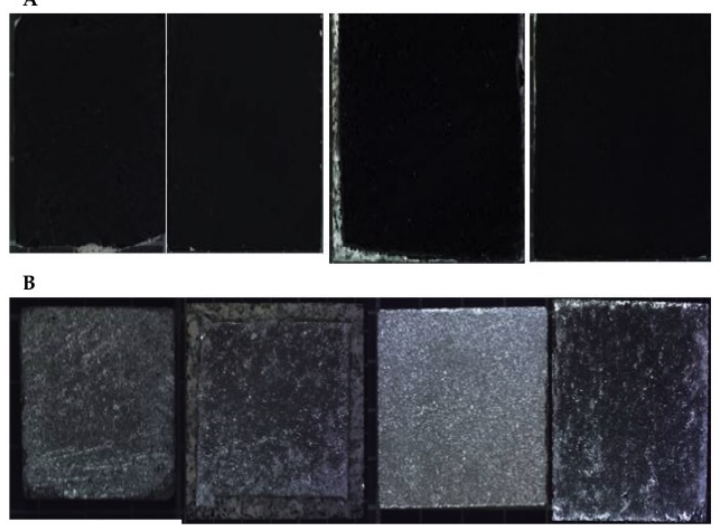
Figure 1. JPEG images of the painted stone samples at the beginning of the experiment. From left to right: ( A ) BCN, IN, GNA, GNB and ( B ) BCP, GPA, IP, GPB. The sample codes are shown in Table 1.